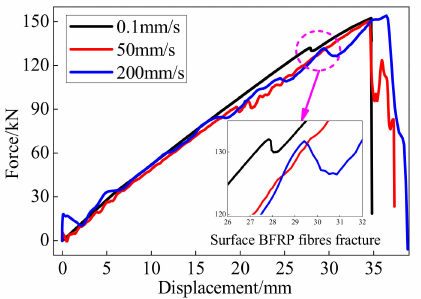
Figure 5. Monotonic performance of the BFRP